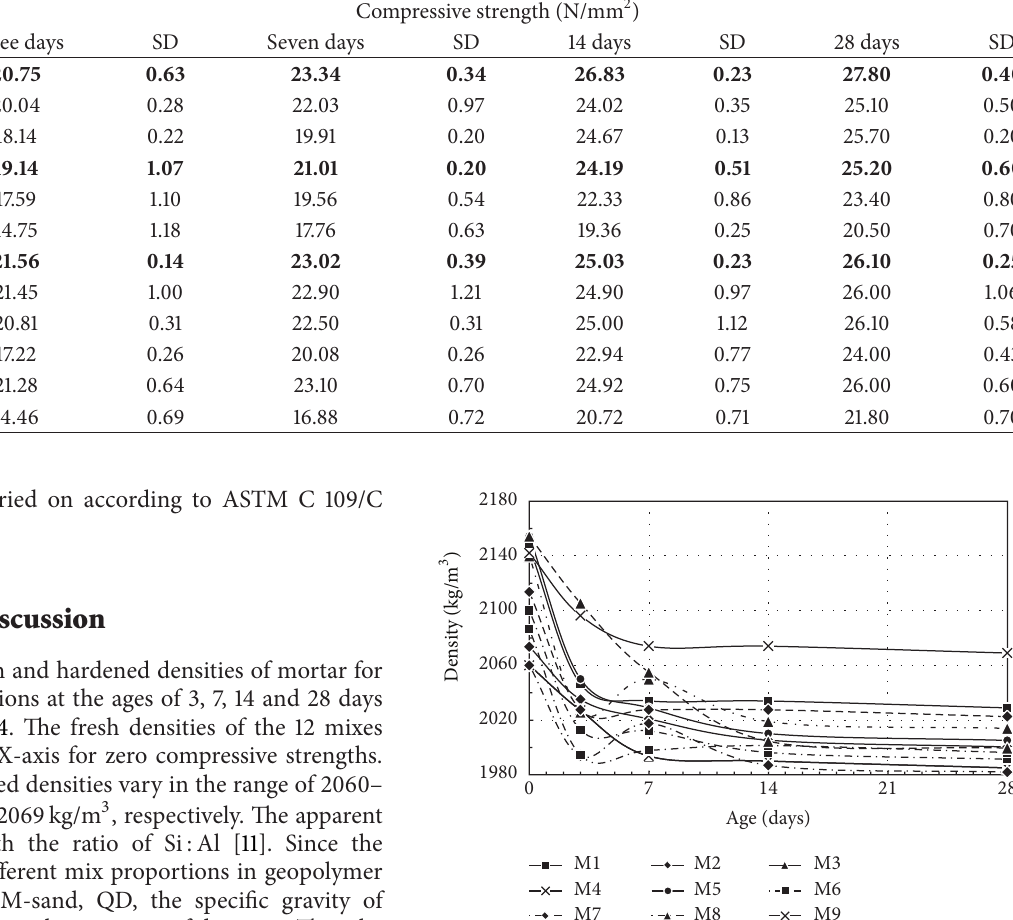
Table 5: Development of compressive strength for different mix designs.